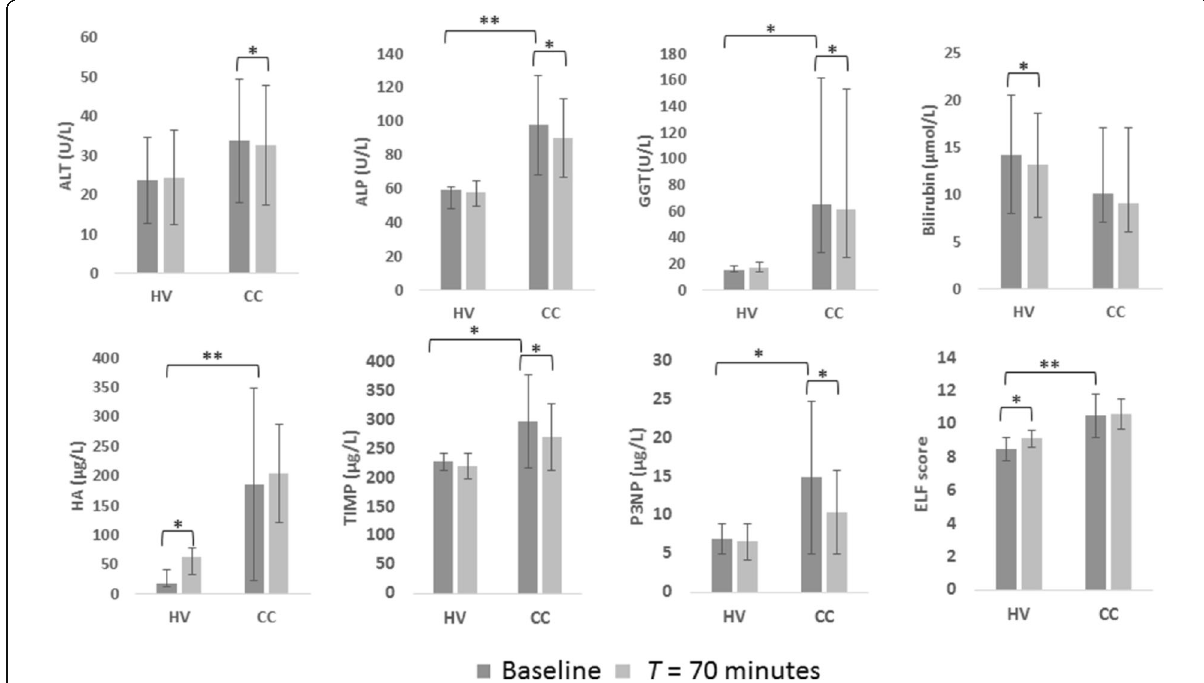
Fig. 2 Serum markers at baseline and at time ( T ) = 70 min following meal ingestion in healthy participants (HV) and patients with compensated cirrhosis (CC). ALT alanine transaminase; ALP alkaline phosphatase; GGT gamma-glutamyl transferase; HA hyaluronic acid; TIMP tissue inhibitor of matrix metalloproteinase 1; P3NP aminoterminal peptide of procollagen III; ELF enhanced liver fibrosis. * p < 0.05, ** p < 0.01